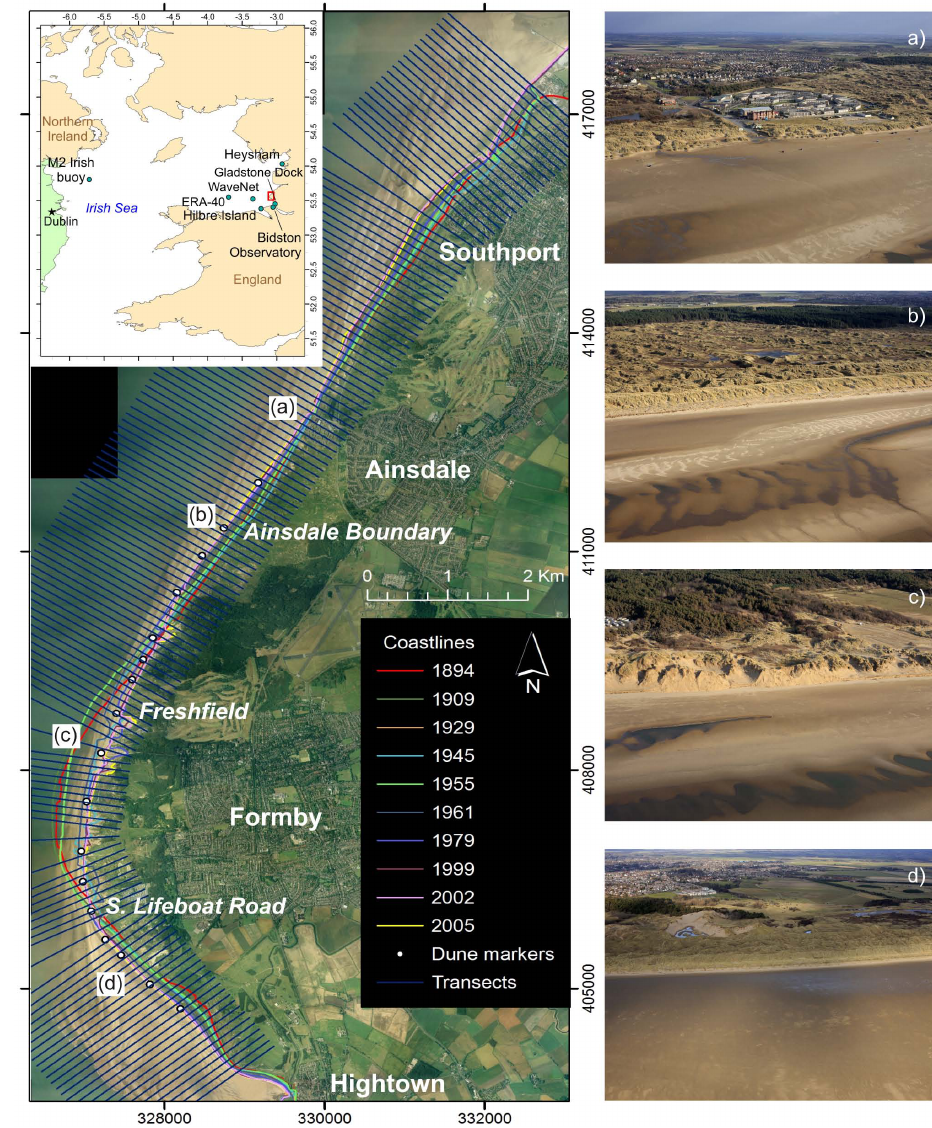
Fig. 1. Field site location showing the position of the coastline at different times and the shoreline transects along which coastline changes were measured. The inset shows the stations where metocean data were collected and the location of the study area (red rectangle). Pho- tographs of the coastline at four locations show: (a) urban development at Ainsdale; (b) accreting dunes south of Ainsdale; (c) eroding dunes at northern Formby Point; and (d) stable vegetated dunes north of